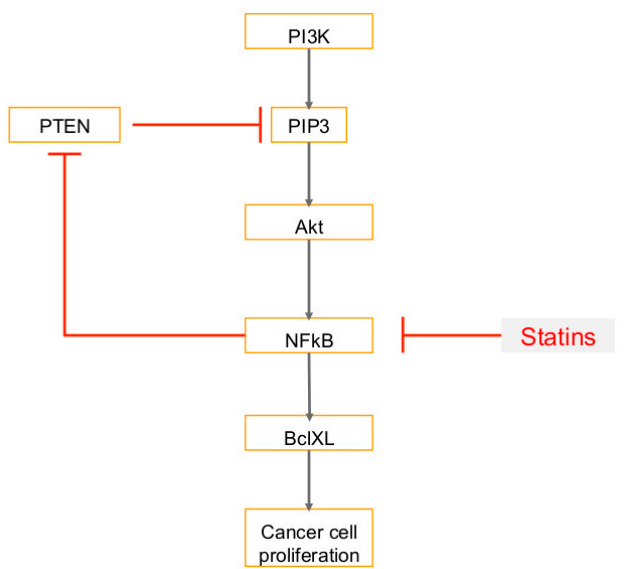
Figure 8. Statin therapy and downstream consequences: Statins block transcription of NFkB. This decreases expression of anti-apoptotic BclXL and inhibits cancer cell proliferation. Inhibition of NFkB also increases expression of pro-apoptotic phosphatase and tensin homolog (PTEN). PTEN inhibits PI3 kinase, and therefore also inhibits the target of PI3 kinase, Akt kinase, which are both associated with the anti-apoptotic properties of cancer cells. T-bars in red denote inhibition.